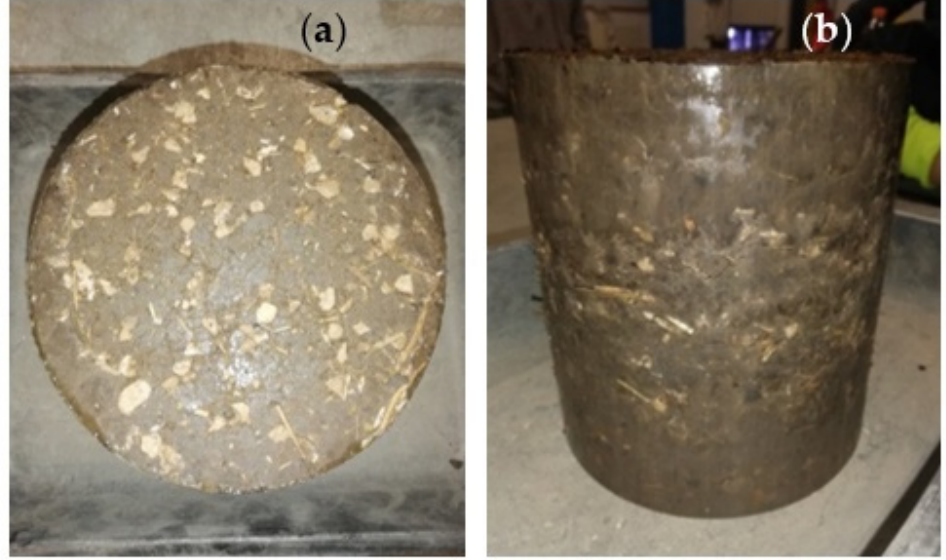
Figure 6. Cylindrical specimen in beaten earth: ( a ) top view; and ( b ) lateral view. Each S3 cylinder has a wet weight of approximately 6.0 kg and a wet density of approximately 2.28 g/cm 3 . The average value of the specimen’s maximum dry densities was 2.07 g/cm 3 , which demonstrates the reliability of the Proctor test considering that the maximum value was equal to 2.05 g/cm 3